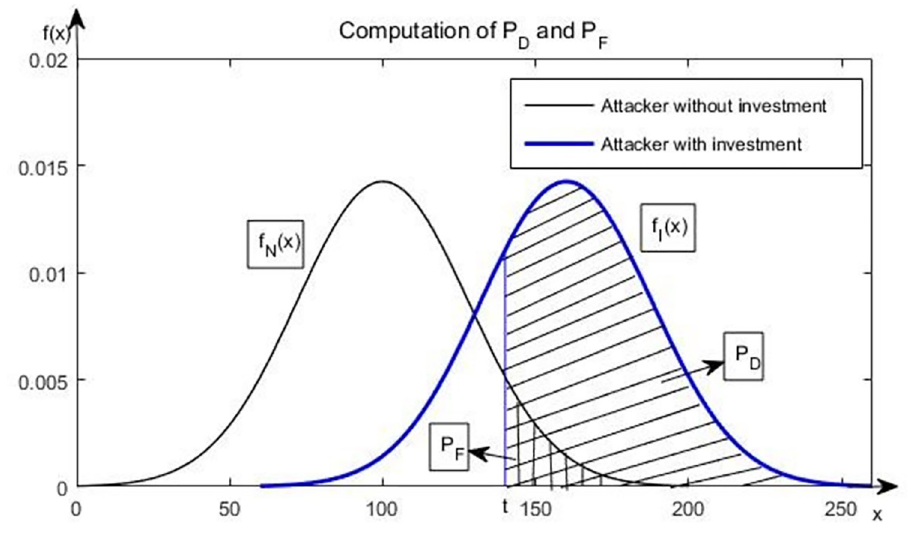
Fig 1. Probability